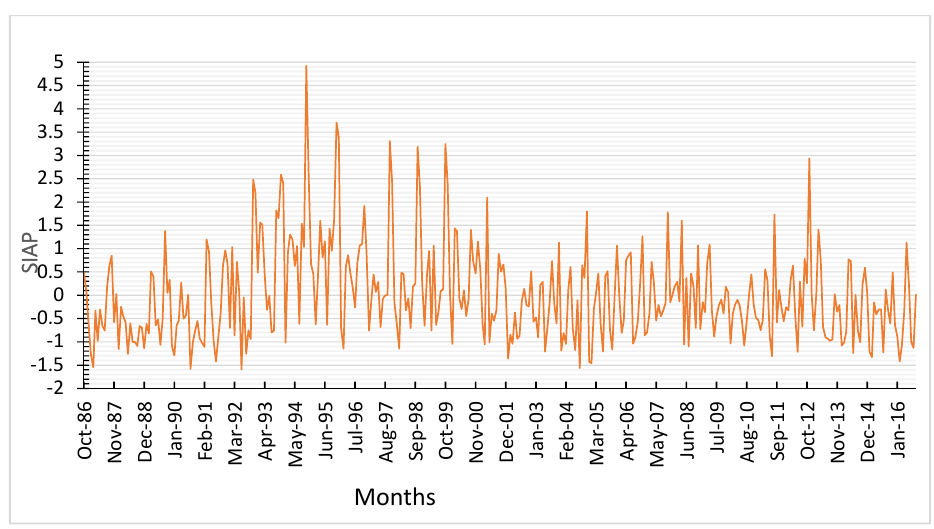
Figure 6. Standard Index of Annual Precipitation (SIAP) values for 30 years at station 2.